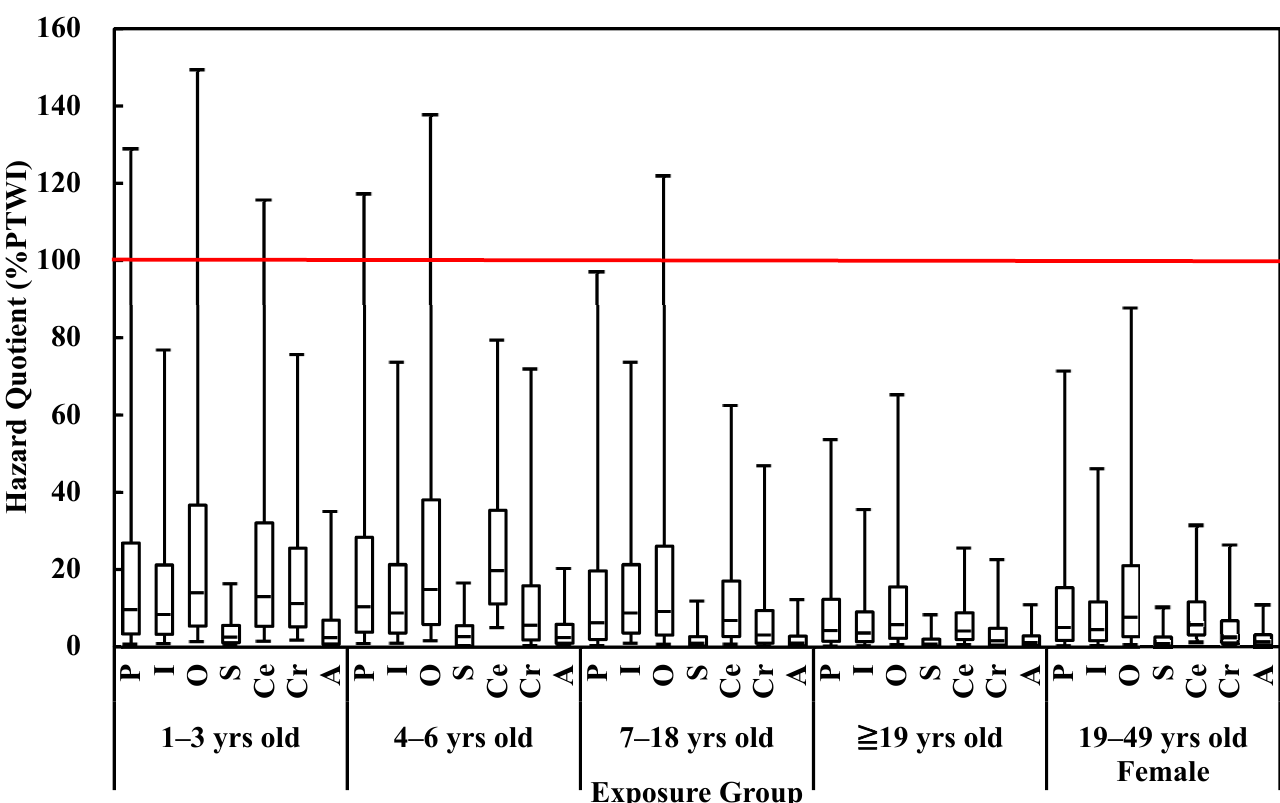
Figure 2. Hazard quotient for the seven categories of seafood among different age groups. P: Pelagic fish; I: Inshore fish; O: Other farmed fish; S: Shellfish; Ce: Cephalopods; Cr: Crustaceans; and A: Algae.